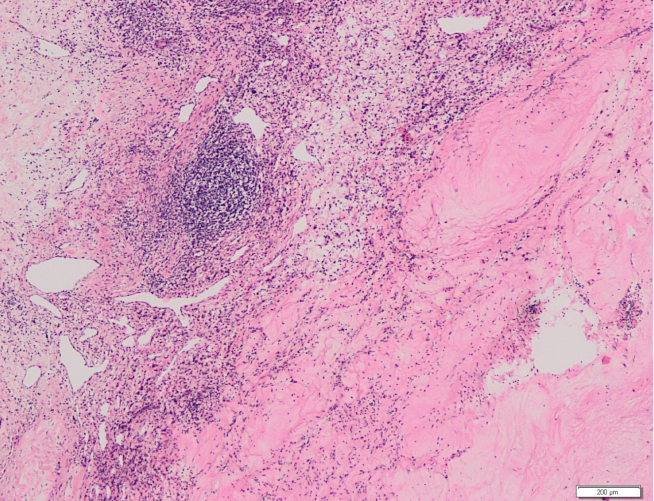
Figure 3. Histopathological examination of the primary tumor after radical nephrectomy showing pathological complete response (pCR). Necrosis, lymphocytic infiltrates, but no residual viable tumor cells are